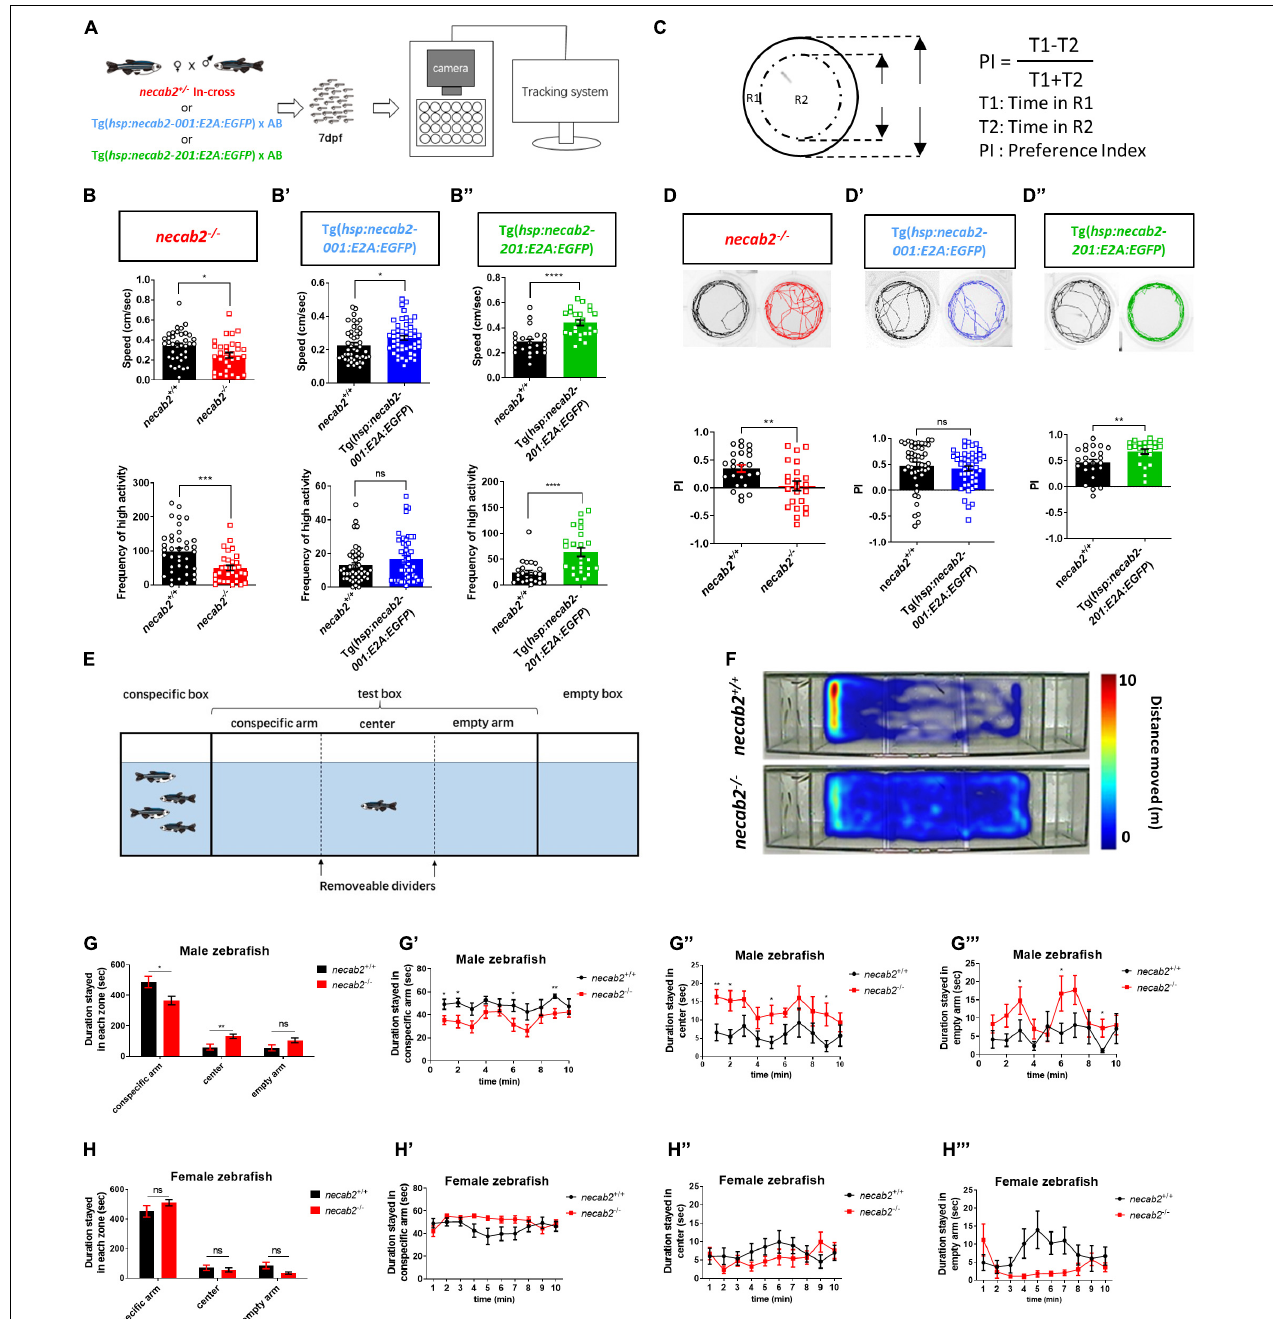
FIGURE 5 | Necab2 is necessary and sufficient to promote psychomotor, thigmotaxis, and social interaction. (A) Workflow and experimental setup. To control for potential differences in the genetic background, tracking experiments were performed blindly on the progeny from heterozygous necab2 + / − mating. Genotyping was done after behavioral tracking by PCR. (B–B (cid:48)(cid:48) ) necab2 − / − (in red, n = 31, with sibling control n = 38) larvae exhibited locomotor hypo-activity while Tg( hsp:necab2-001:E2A:EGFP ) larvae (in blue, n = 48, with sibling control n = 45) and Tg( hsp:necab2-201:E2A:EGFP ) larvae (in green, n = 24, with sibling control n = 24) yielded the opposite. (ns p ≥ 0.05, * p < 0.05, *** p < 0.001, **** p < 0.0001, Student’s t -test or Mann-Whitney U test). (C) Diagram of the thigmotaxis behavior test. The equation for calculating the preference index (PI) was shown at right. PI was calculated as the subtraction of the locomotion duration in the outer region (R1) and inner region (R2) divided by the total duration. R1 and R2 were of the same area. (D–D (cid:48)(cid:48) ) The necab2 − / − (in red, n = 23, with sibling control n = 24) larvae exhibited decreased preference for the periphery region while Tg( hsp:necab2-201:E2A:EGFP ) larvae (in green, n = 23, with sibling control n = 24) yields the opposite. Tg( hsp:necab2-001:E2A:EGFP ) larvae (in blue, n = 48, with sibling control n = 47) showed no difference. (ns p ≥ 0.05, ** p < 0.01, Student’s t -test or Mann-Whitney U test). (E) Diagram of the three-chamber social behavior test. Four unfamiliar conspecifics with mixed-sex were placed in the conspecific